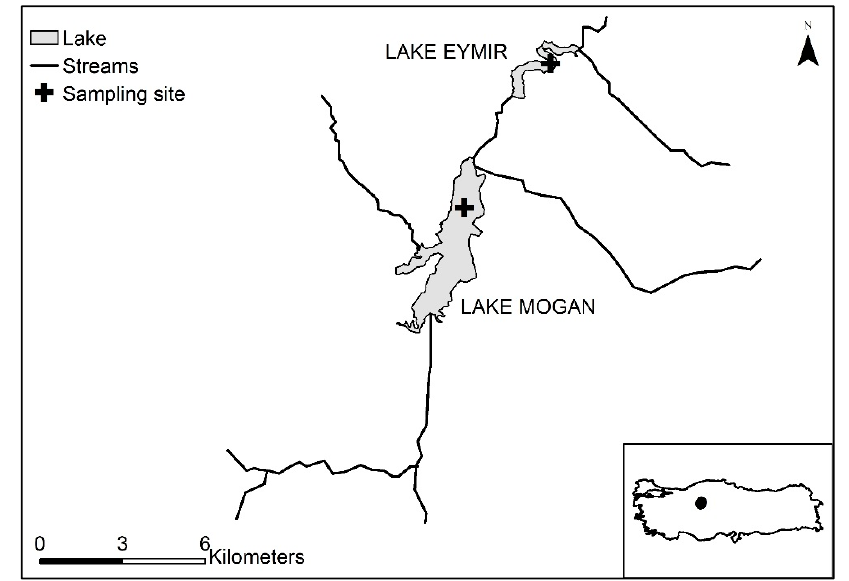
Figure 1. Location of the study lakes and sampling sites. The map is modified from Coppens et al. [ 19 ] .